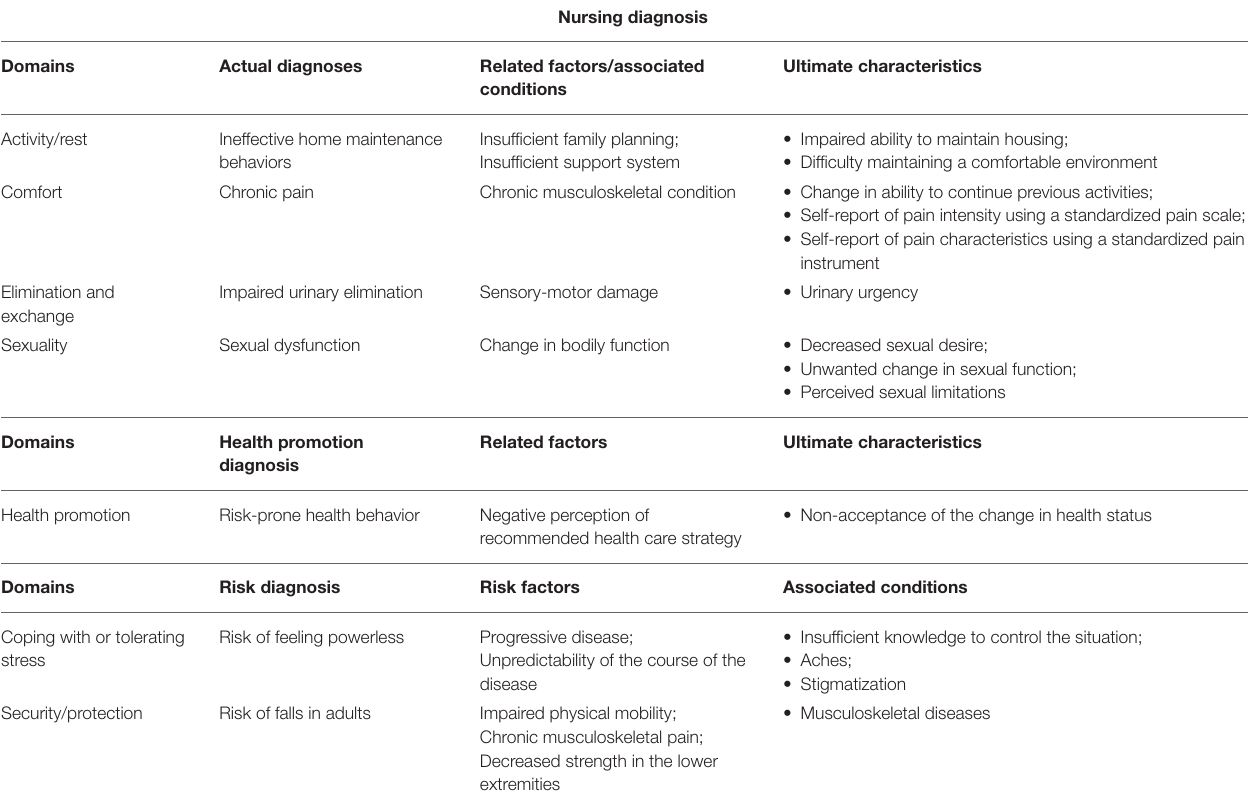
TABLE 1 | NANDA-I nursing diagnoses of patients with HTLV-1.